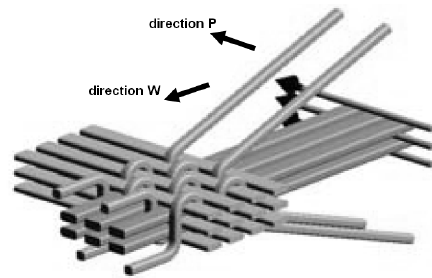
Figure 8. Schematic diagram of the reinforcement structure of a 3D non-crimp fabric (NCF) fabric by 3TEX [65].